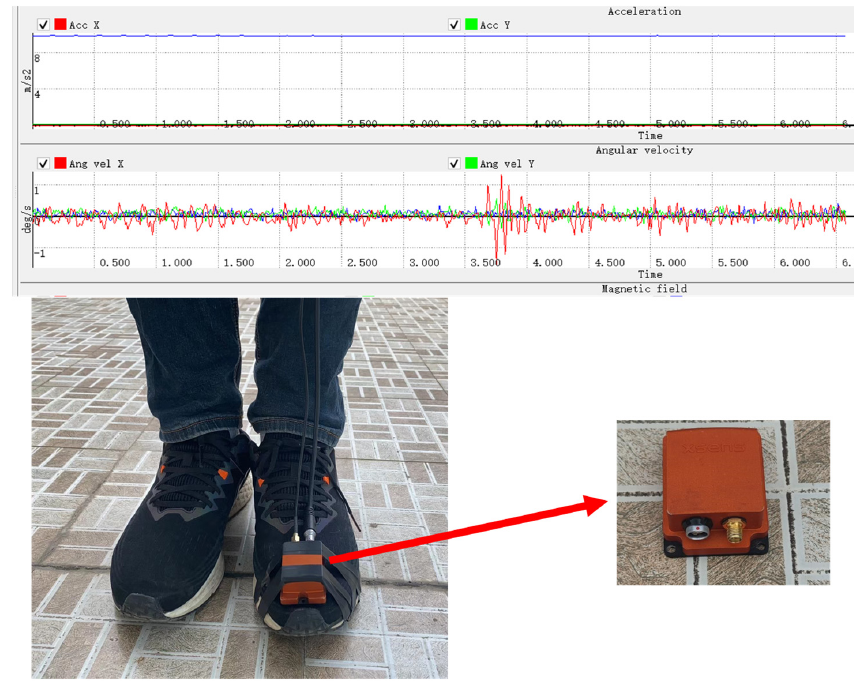
Table 2. Performance parameter of MTI ‐ 710.